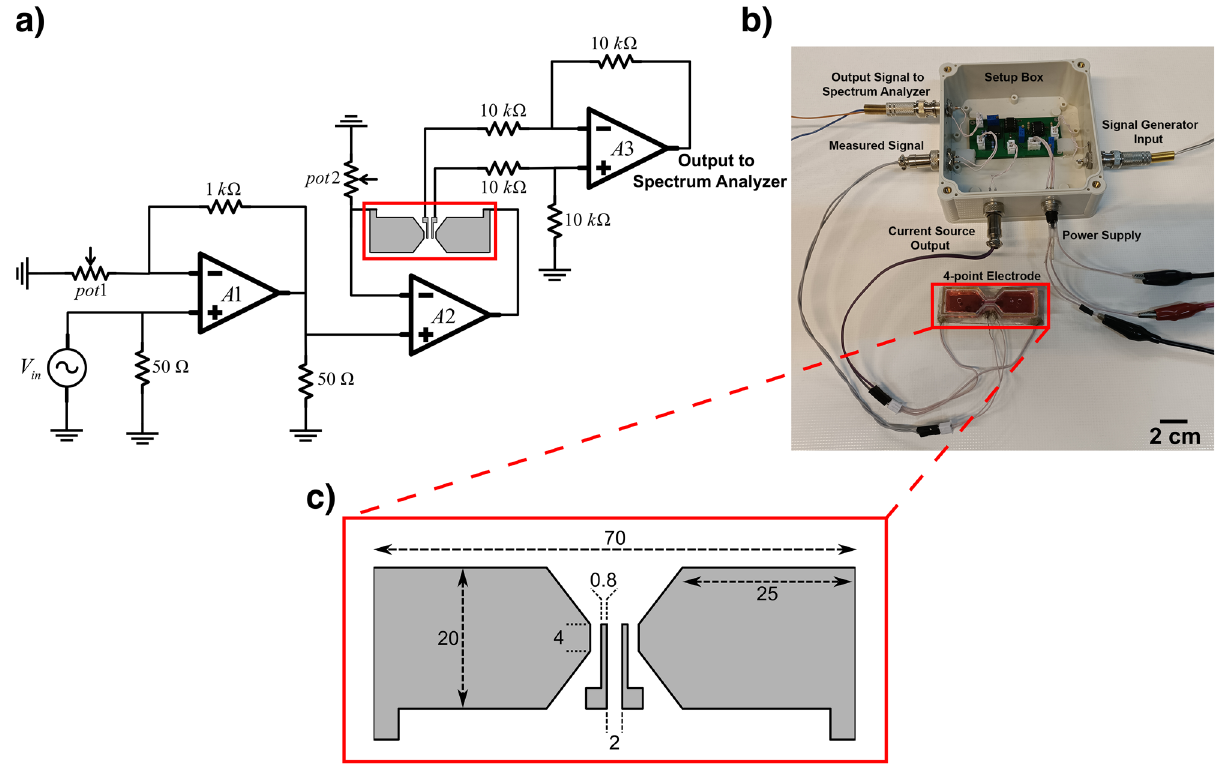
Figure 4. The NLDS biosensor ( a ) electronic deriving circuit, ( b ) measurement setup and ( c ) detailed drawing of the biosensor configuration showing the electrodes in gray and the size of different elements and recording chamber in